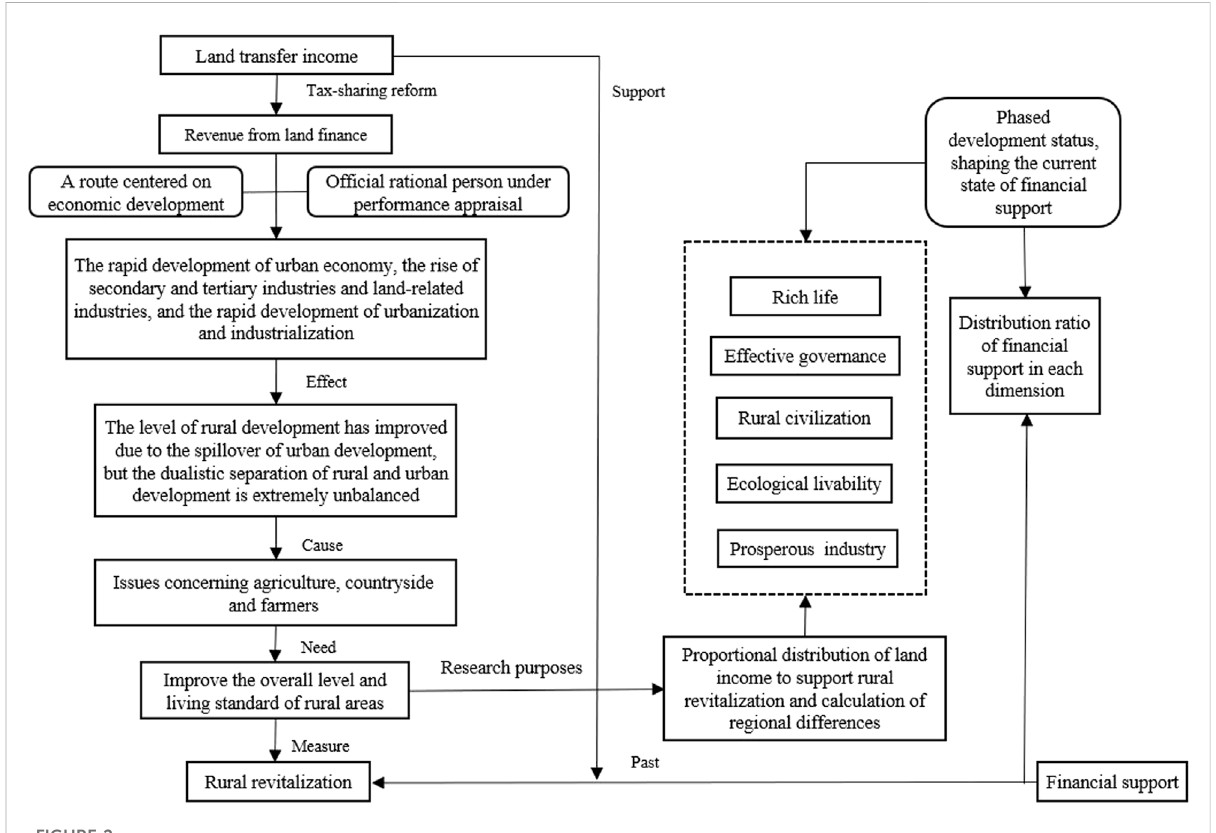
FIGURE 2 Operation mechanism of how land transfer income is used to support rural